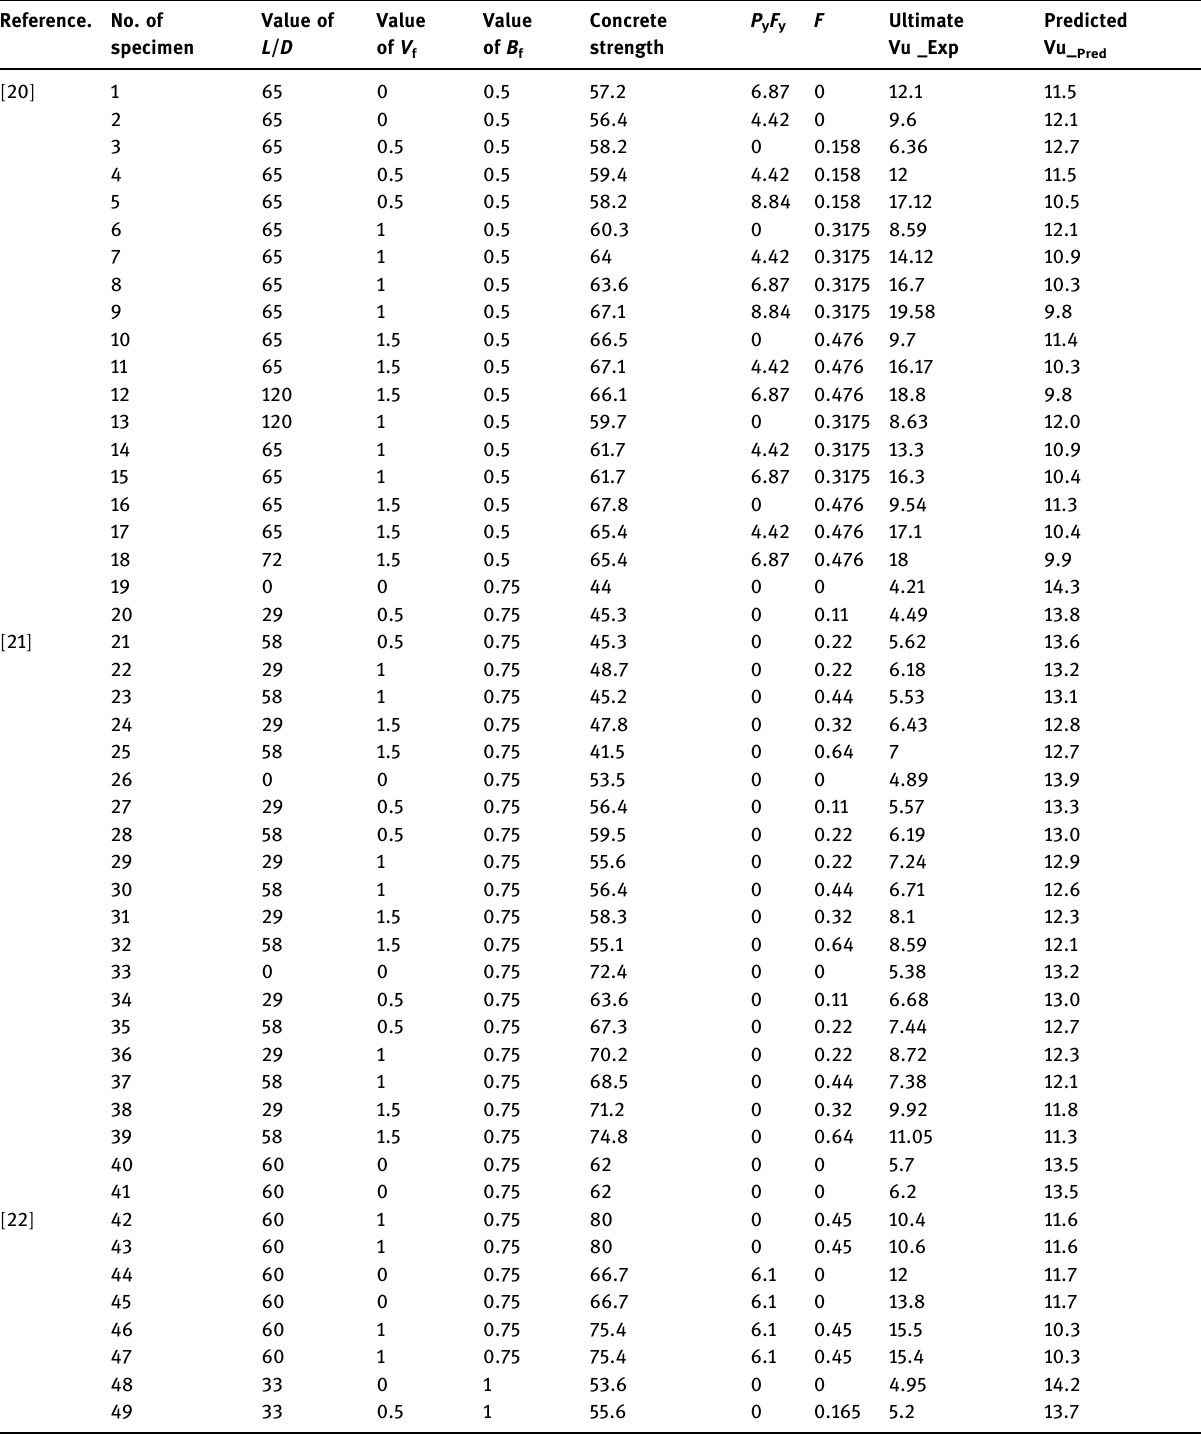
Table A1: Input data of the proposed recent ANN model and its references Reference. No.